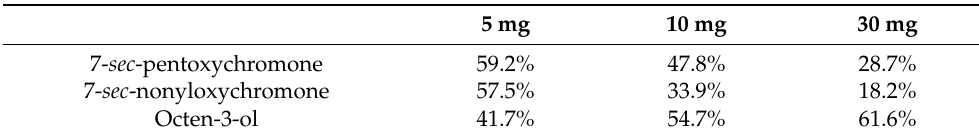
Table 20. Comparison of attractant effects (KI) of 7- sec -pentoxychromone ( 11 ), 7- sec - nonyloxychromone ( 12 ), and octen-3-ol.